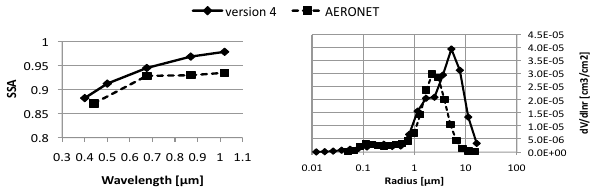
Fig. 13. SSA and SDF in Beijing retrieved by version 4 (solid line;